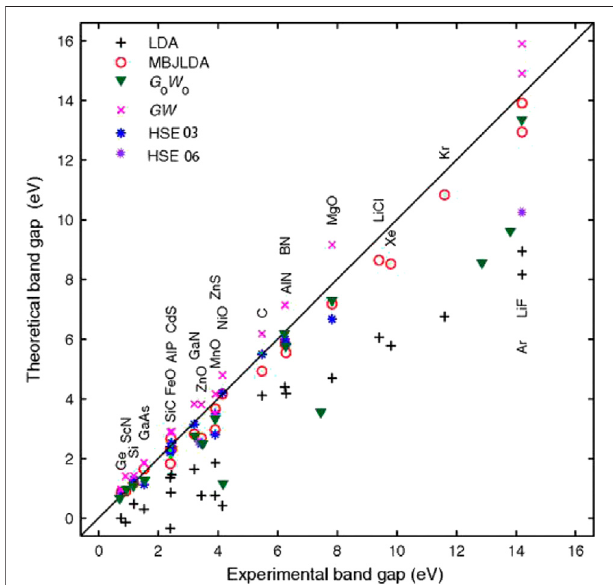
FIGURE 12 | Theoretical and experimental bandgaps of 23 different solid compounds calculated by various DFT methods, including the LDA (plus sign), MBJLDA potentials (hollow circle) and other methods, include HSE03 (blue asterisk) and HSE06 (purple asterisk), all-electron non-self- consistentG 0 W 0 (triangles)andself-consistentGW(crosses).Formostcases, the MBJLDA potential yields bandgaps which are in good agreement with the experiment leading to typical errors of less than